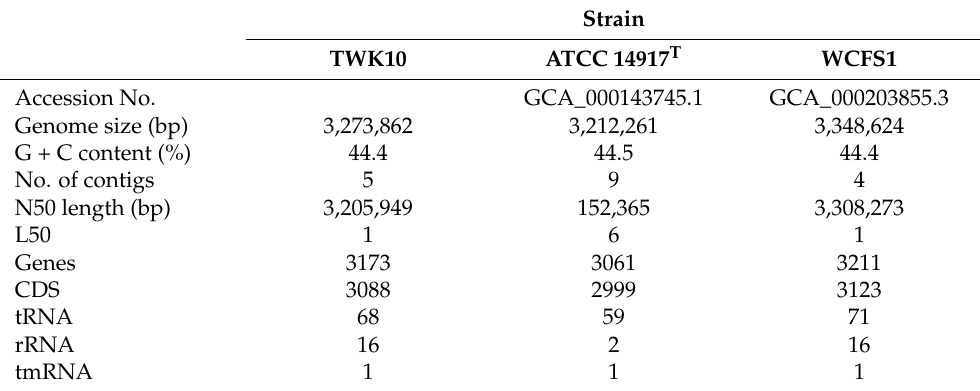
Table 1. Comparison of the genomic features of Lactiplantibacillus plantarum strains TWK10, ATCC 14917 T , and WCFS1. Strain TWK10 ATCC 14917 T WCFS1 Accession No. GCA_000143745.1 GCA_000203855.3 Genome size (bp) 3,273,862 3,212,261 3,348,624 G + C content (%) 44.4 No. of contigs 5 N50 length (bp) 3,205,949 152,365 L50 1 1 Genes 3173 3061 3211 CDS 3088 2999 3123 tRNA 68 59 71 rRNA 16 2 16 tmRNA 1 1